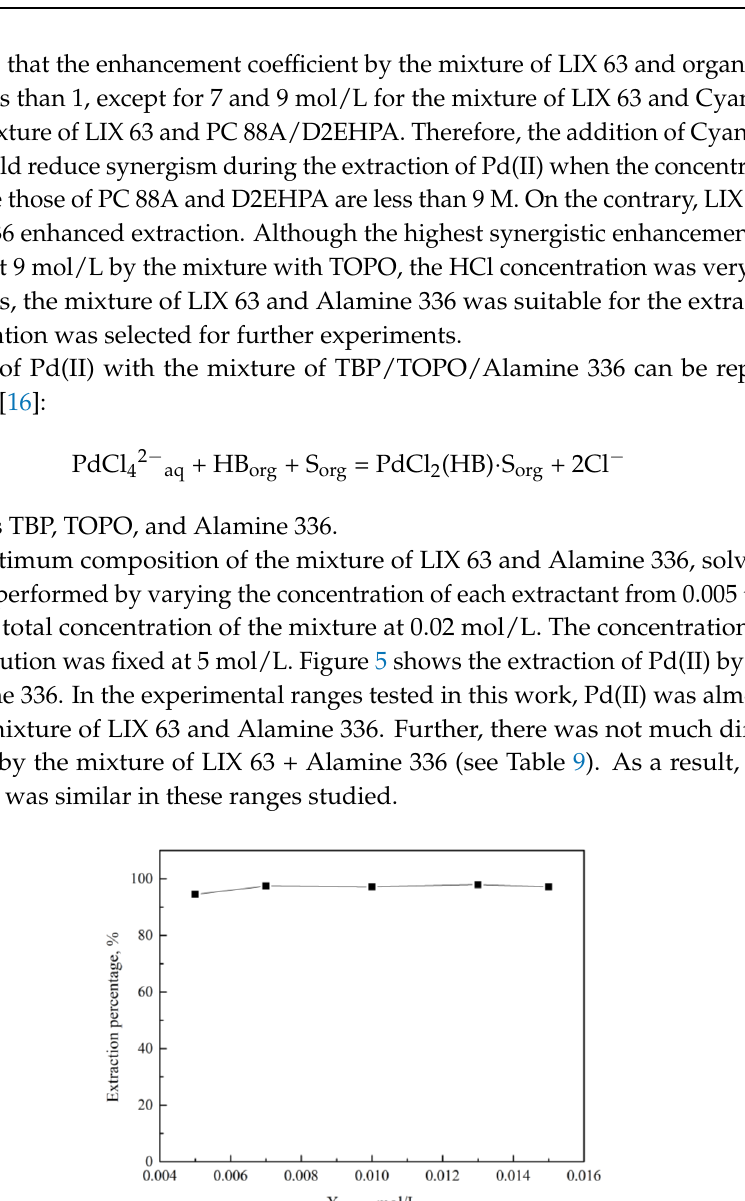
Table 8. Synergistic enhancement coefficient ( R ) of Pd(II) with mixture of 5,8-diethyl-7- hydroxyldodecane-6-oxime (LIX 63) and various extractants.